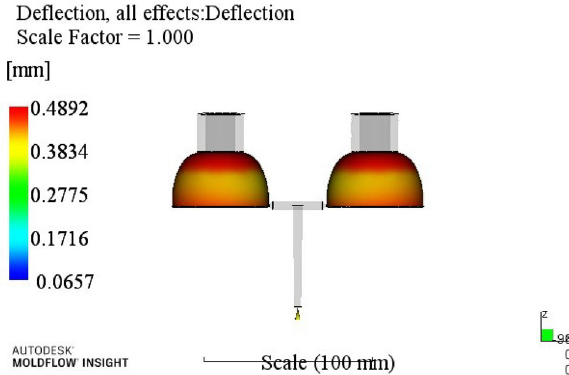
Figure 12. The optimized warping value.